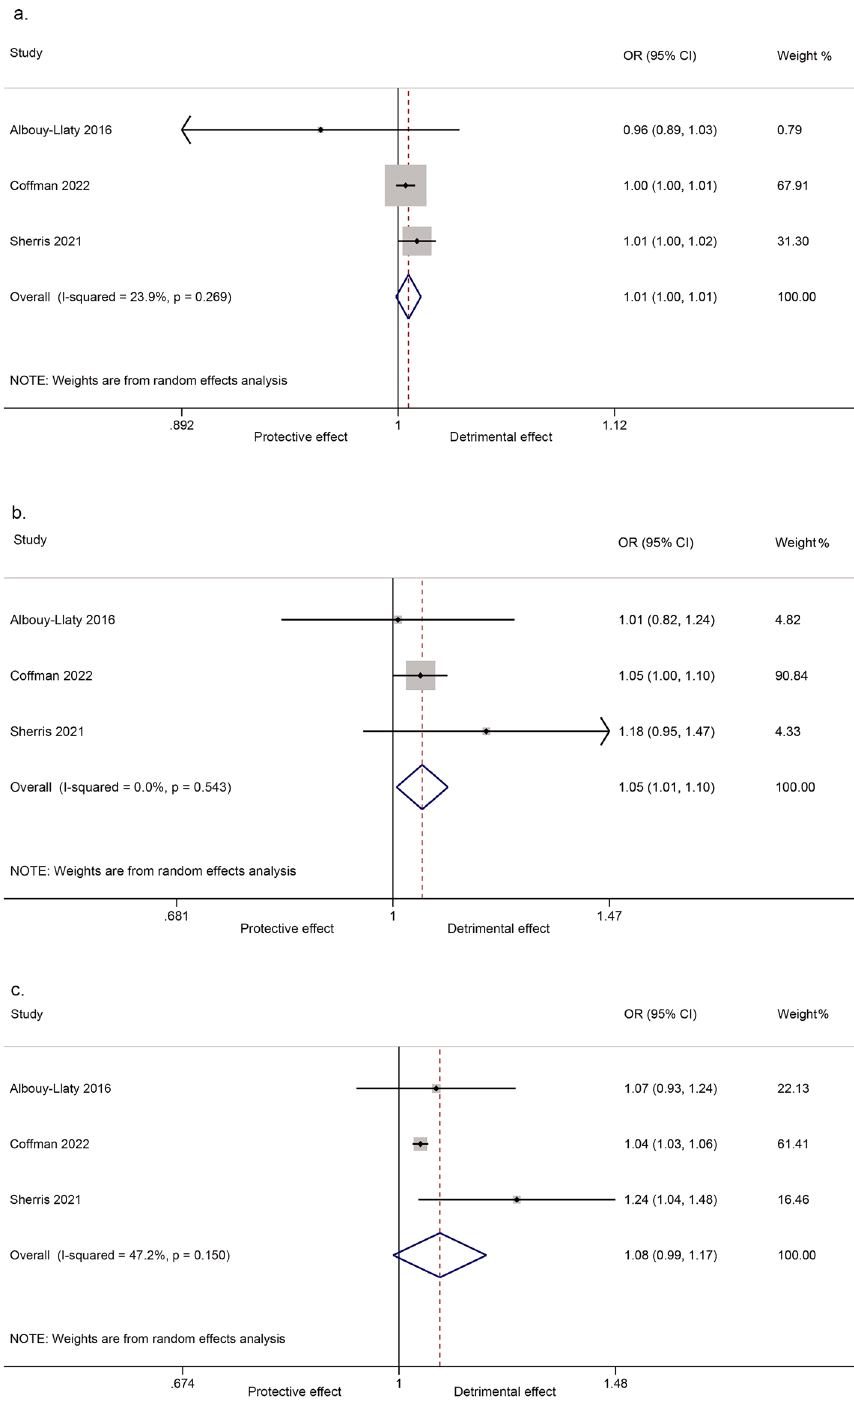
Figure 2. Forest plot for the association between nitrate in drinking water and preterm birth. ( a ) Linear relationship; ( b ) Highest versus lowest exposure; ( c ) All combined higher versus the lowest